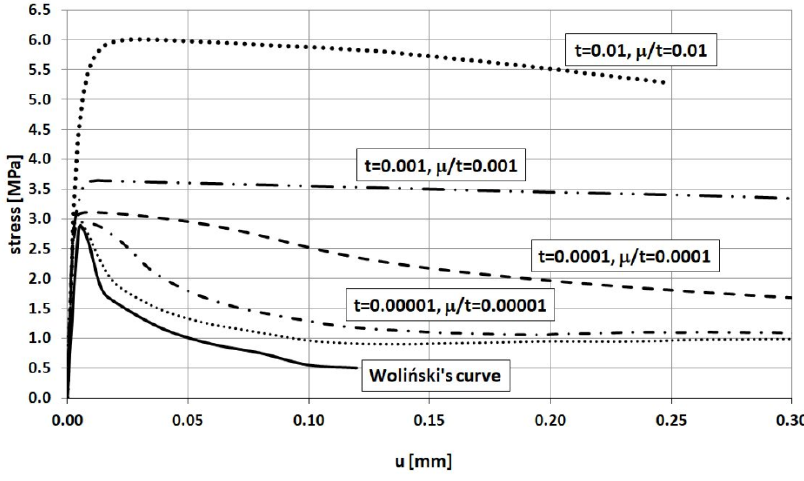
Figure 10. Displacement vs. stress relationship obtained for different relaxation time values.